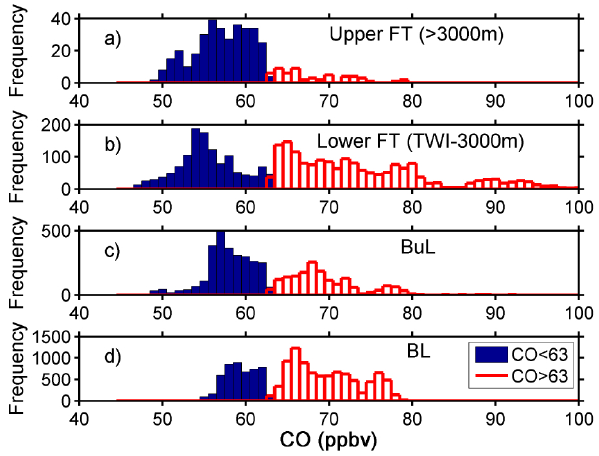
Fig. 8. Histograms of observed CO concentrations during PASE for indicated altitude ranges. A few measurements in the lower FT ex- ceeded 100ppbv but are not shown here for plot